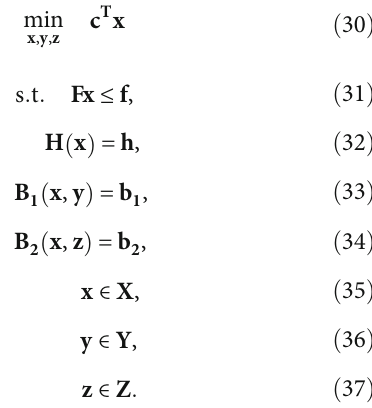
Figure 5: Two-level architecture of the proposed decomposition algorithm for the PMP